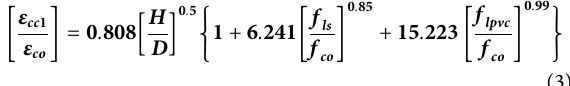
Eq. 3 is applicable for CFPT con fi ned concrete columns including the effect of slenderness ratio, stresses in steel and PVC pipes, as well as for uncon fi ned CFPT columns. Whereas, ε fi ned concrete strength at peak load, H is the co is 0.002 for uncon height (mm) of column and D is diameter (mm) of the column. Lateral con fi nement pressure provided by the hoop steel reinforcement is determined by Equation 4 Where, k es is the con fi nement effectiveness coef fi cient of the hoop reinforcement in the horizontal plane. The coef fi cient, k es is the ratio of effectively con fi ned concrete area to the con fi ned area and it is determined from Equation 5. For circular columns, the effectively con fi ned area is equal to the con fi ned area and hence k es (cid:1) 1 . 0. ρ , is the volumetric ratio of the hoop reinforcement, st f yt is the yield strength of the steel. k v is the coef fi cient, which accounts for the effectiveness of lateral con fi nement provided by the hoop and longitudinal reinforcement in the longitudinal direction between the transverse hoop reinforcement. For circular concrete con fi ned column with circular hoop reinforcement kv is proposed by Mander et al. (1988).